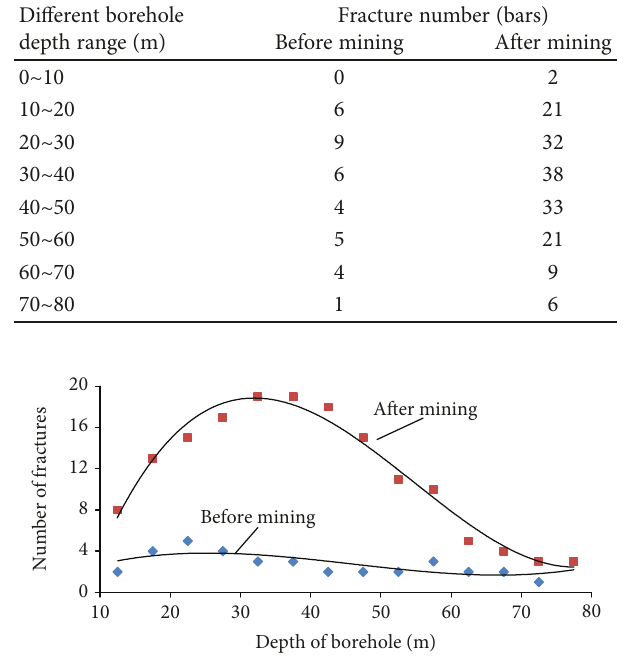
Figure 11: Relationship curves between borehole depth and fractures ’ quantity before and after